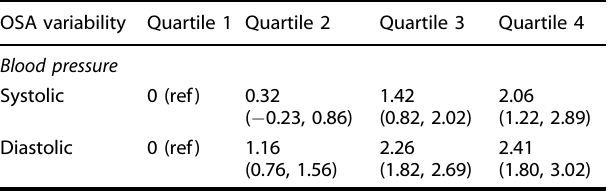
Table 3. β coef fi cients (mean and 95% con fi dence interval) of the association between quartiles of night-to-night variability in obstructive sleep apnea (OSA) severity with diastolic and systolic blood pressure.